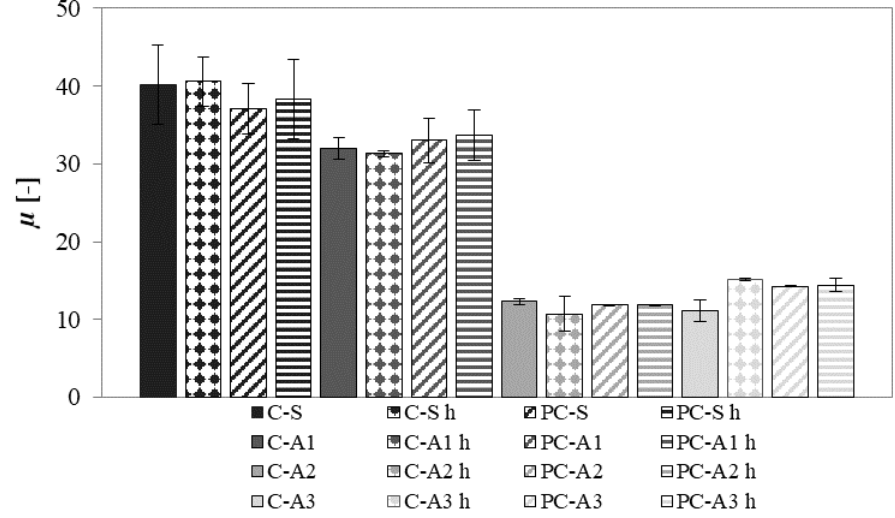
Figure 8. Water vapour resistance factor µ of mortars.